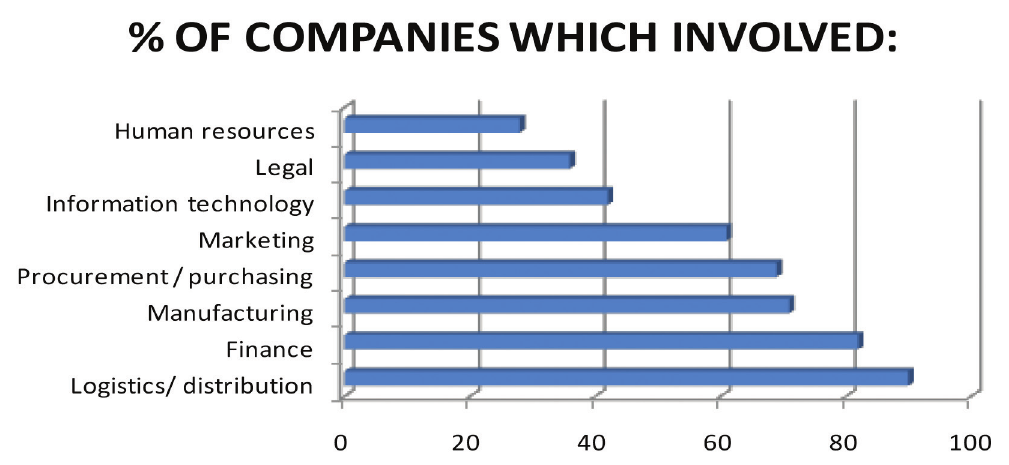
Figure 1: Managerial involvement by respondent